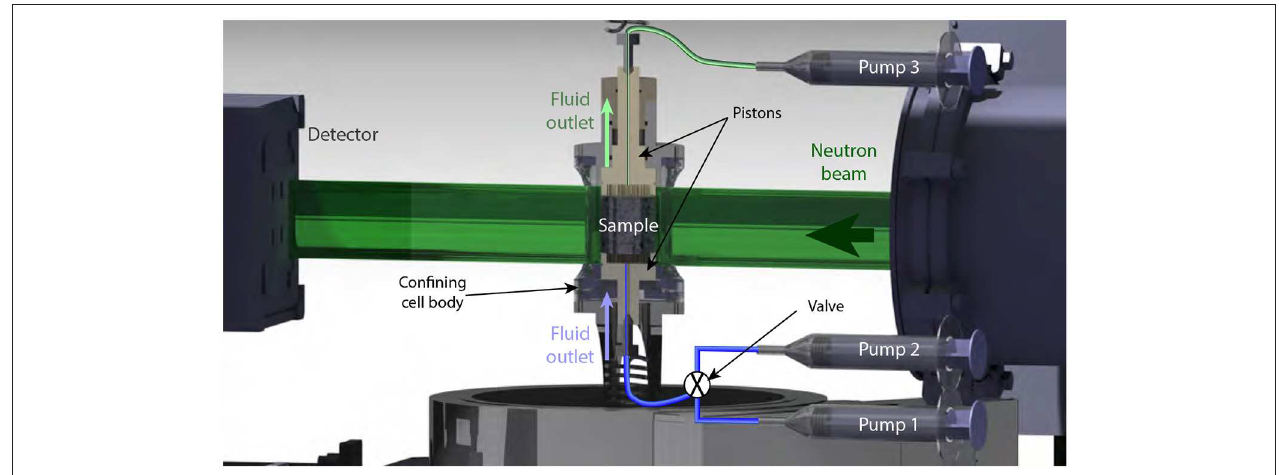
FIGURE 1 | Experimental set-up. A core holder pressurized with nitrogen gas is placed on the rotary stage of the neutron beamline. The sample in the autoclaveA is filled from its bottom side by using one of the two injection pumps. The fluid is recovered by the third pump connected to the top of the sample.